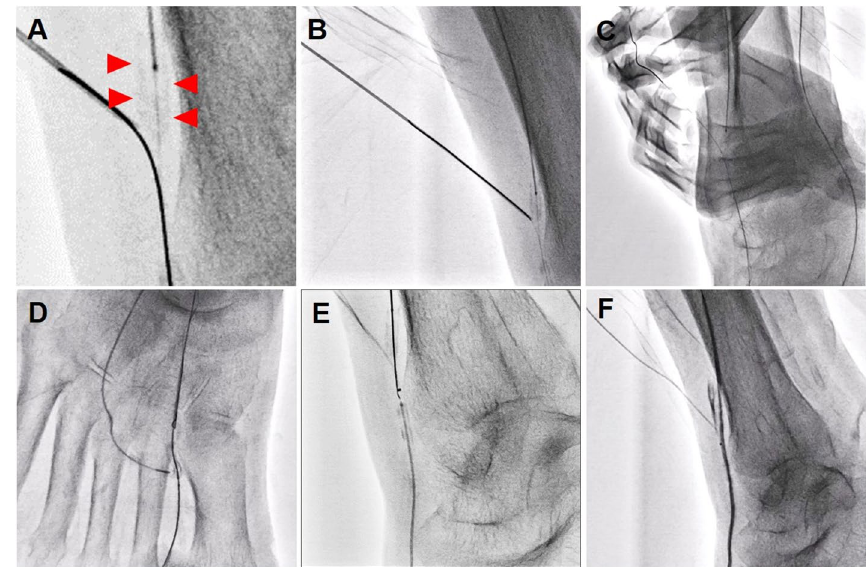
Fig. 3 a Third distal puncture of the distal ATA occlusion making the vessel calcification as a target under fluoroscopy guidance (Arrowheads). b The retrograde Naveed Hard30 guidewire insertion into the puncture needle. c Second guidewire externalization. d Successful retrograde Corsair Armet microcatheter advancement into the occluded DA using the balloon deployment using forcible manner technique. e Antegrade